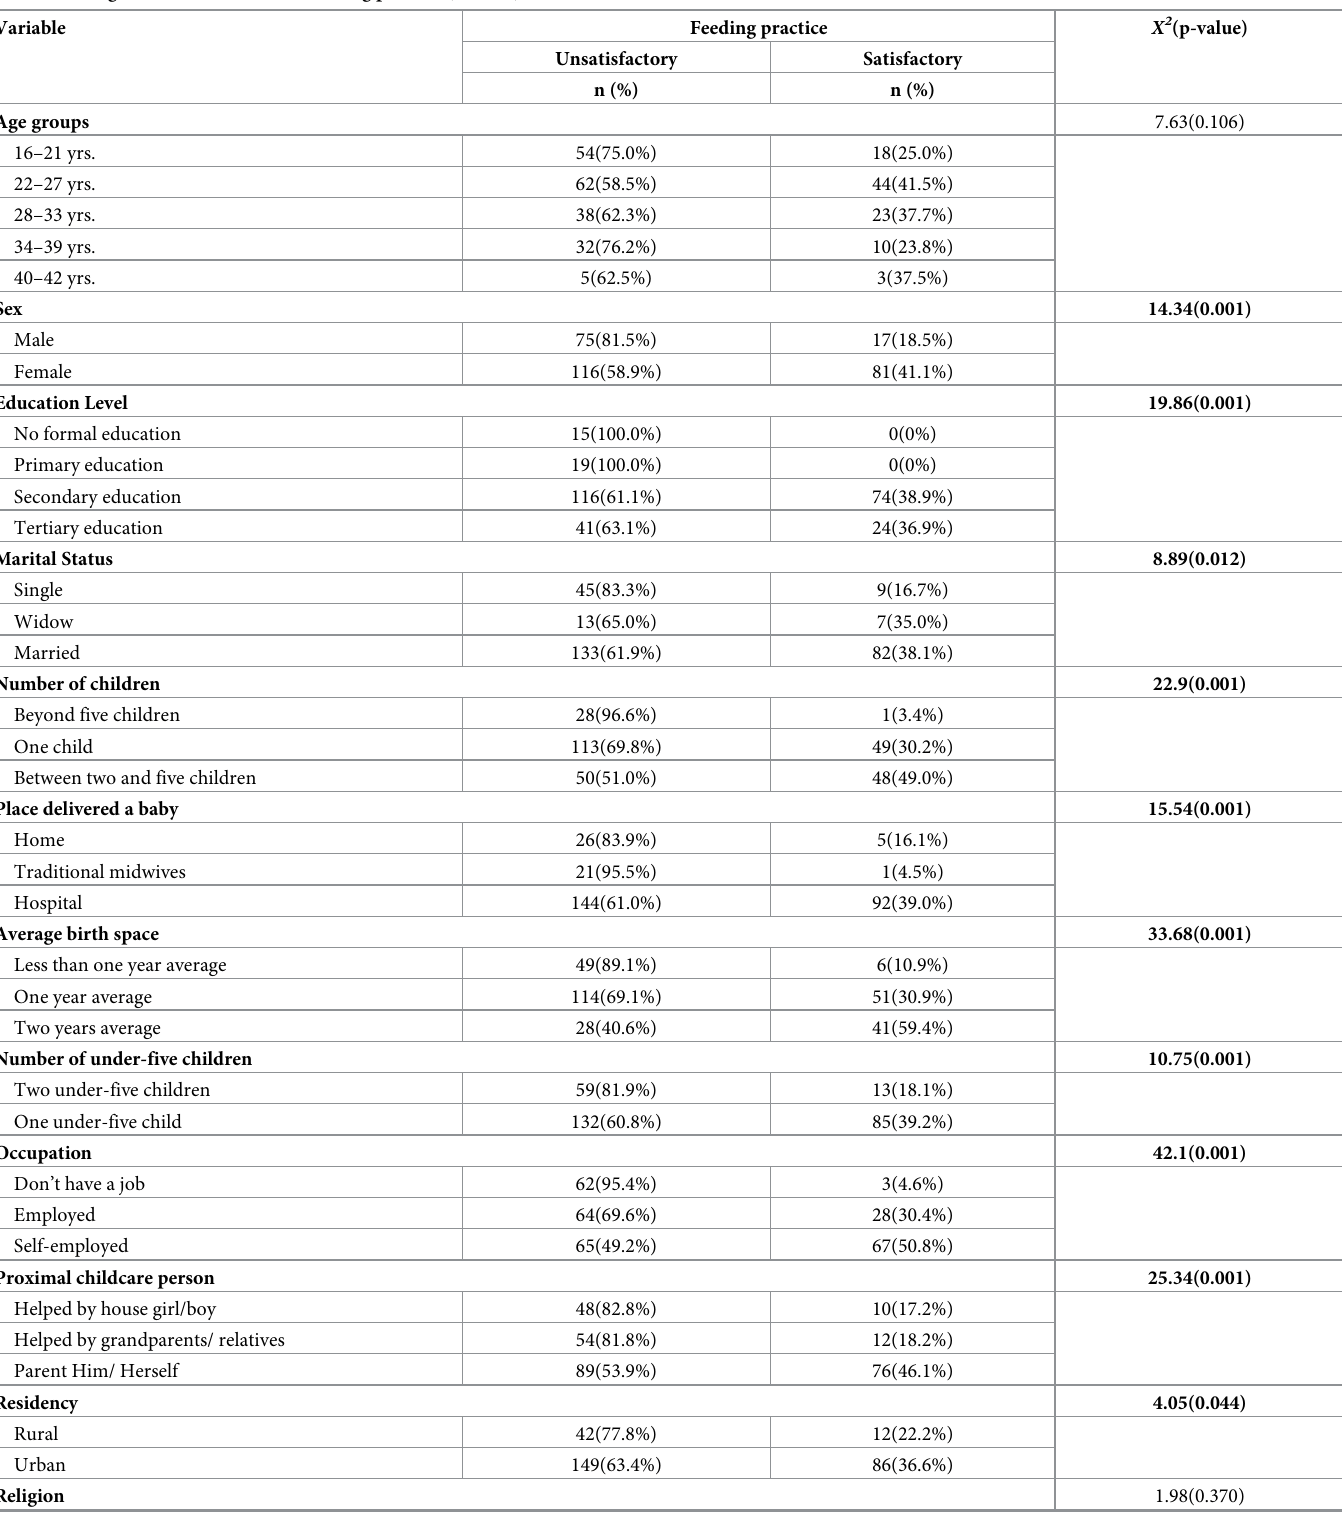
Table 3. Caregivers’ factors related to feeding practice (n =